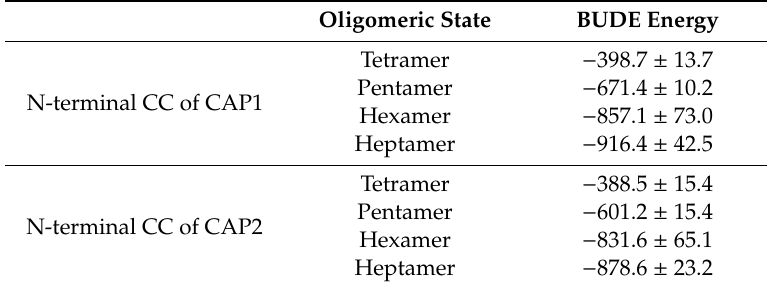
Table 2. Predicted energies of N-terminal coiled-coil (CC) oligomers of human CAPs: provided values are means and standard deviations of 10 best scores of twenty Bristol University Docking Engine (BUDE) energies calculated by CCBUILDER